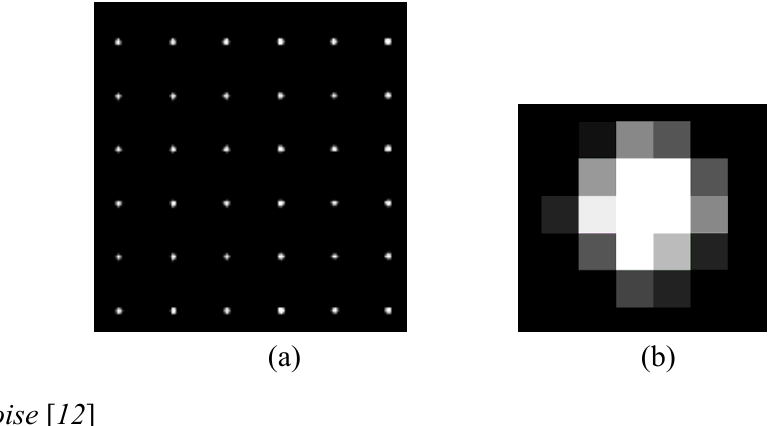
Figure 10. (a) Sun spots array image. (b) Single sun spot